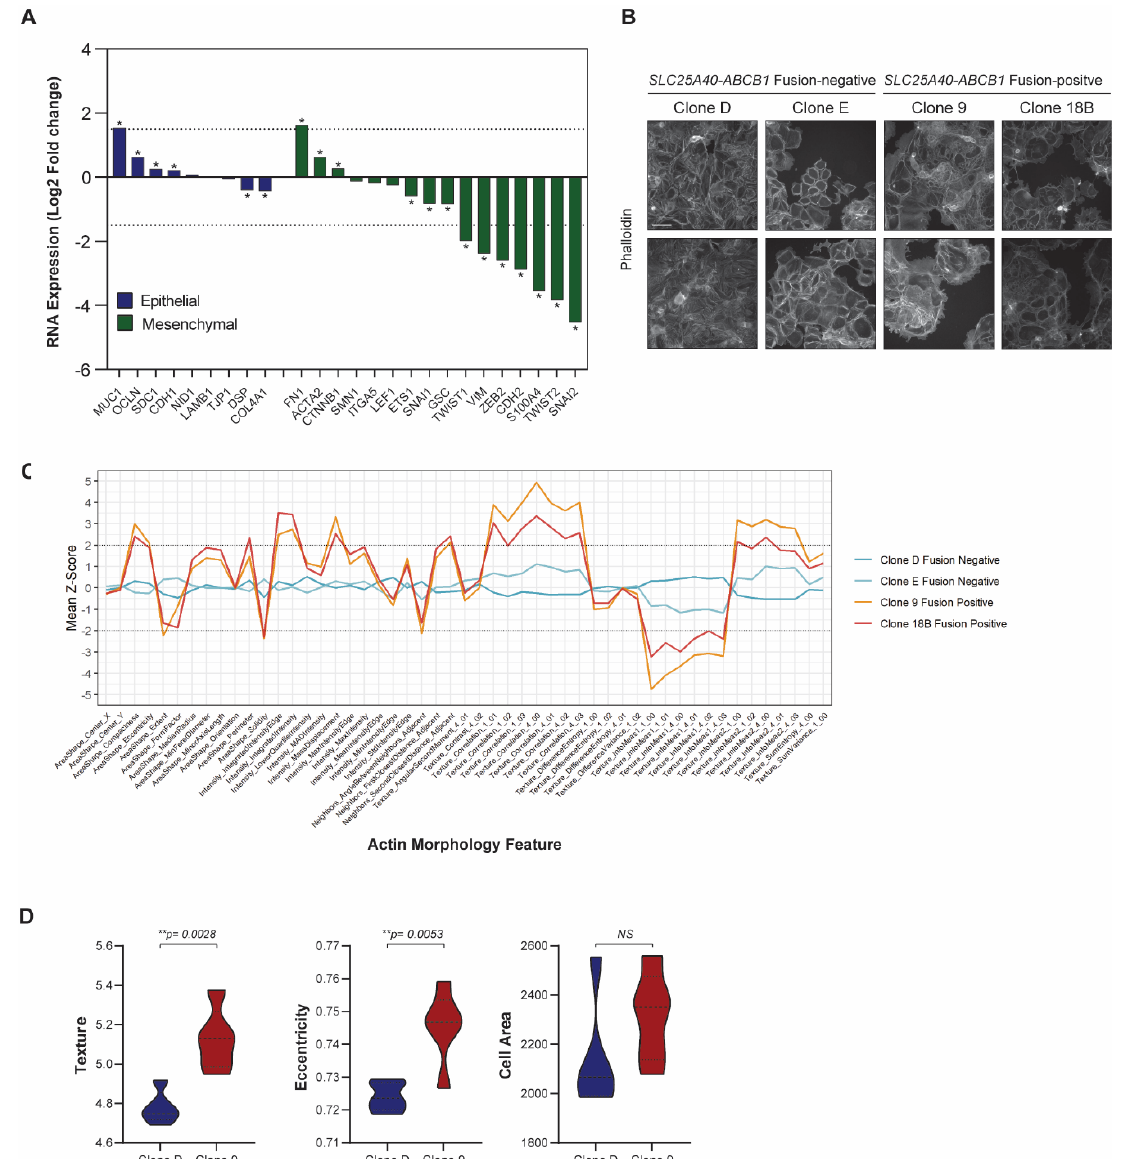
Figure 4. SLC25A40-ABCB1 fusion-positive cells display strong downregulation of mesenchymal genes. ( A ) RNA expression of well-established epithelial ( n = 9, blue) and mesenchymal markers ( n = 16, green) in SLC25A40-ABCB1 fusion-positive clones relative to their fusion-negative counterparts. Asterisks denote statistical significance * p < 0.05. ( B ) Representative phalloidin staining of F-actin filaments in AOCS18.5 fusion-negative (Clone D, E) and fusion-positive (Clone 9, 18B) clones. Pictures taken at 10× magnification with 100 µM scale bar shown. ( C ) Phenotypic profiles showing 51 actin morphology features across AOCS18.5 fusion-negative and positive clones. Values were normalized by fold changing to the median of Clone D and Clone E cells (baseline). Z-Scores reflect the difference between a particular cell line and the median of clone D and E. ( D ) IncuCyte cell-by-cell analysis comparing texture, area and eccentricity of SLC25A40-ABCB1 fusion-negative (blue) and fusion-positive (red) AOCS18.5 clones. Data represents mean feature ± SEM from 4 independent replicates (500 cells minimum). Asterisks denote statistical significance ** p < 0.01 .